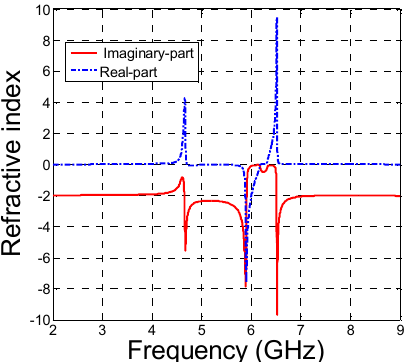
FIGURE 8. the real and imaginary parts of effective refractive index of the four C-HMC BPF.